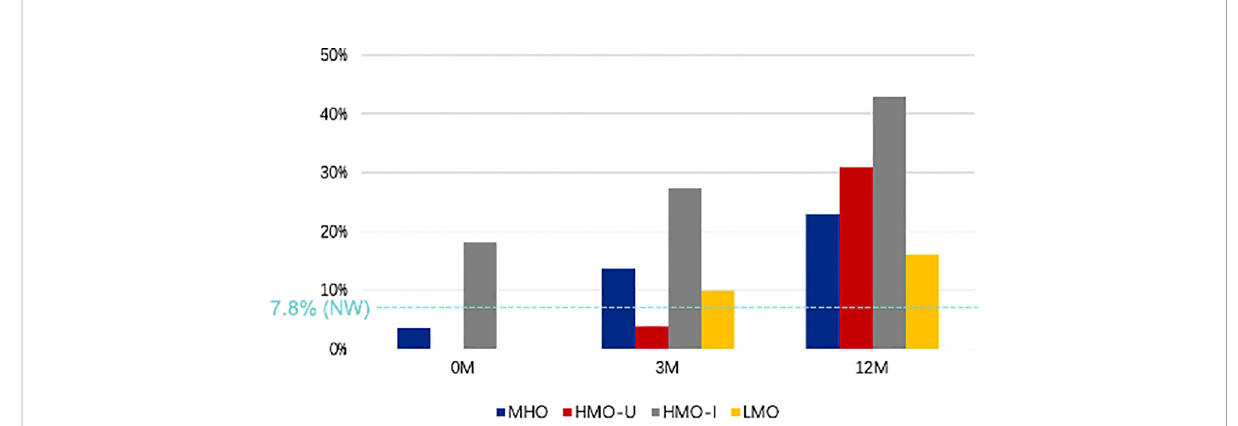
FIGURE 4 Comparison of different AIM subgroups of obesity for the rate of hypoglycemia during OGTT at baseline and at 3- and 12-month post-surgery. MHO, metabolic healthy obesity; HMO-I, hypermetabolic obesity hyperinsulinemia subtype; HMO-U, hypermetabolic obesity hyperuricemia subtype; LMO, hypometabolic obesity; NW, normal weight control; 0M, pre-surgery; 3M, 3-month post-surgery; 12M, 12-month